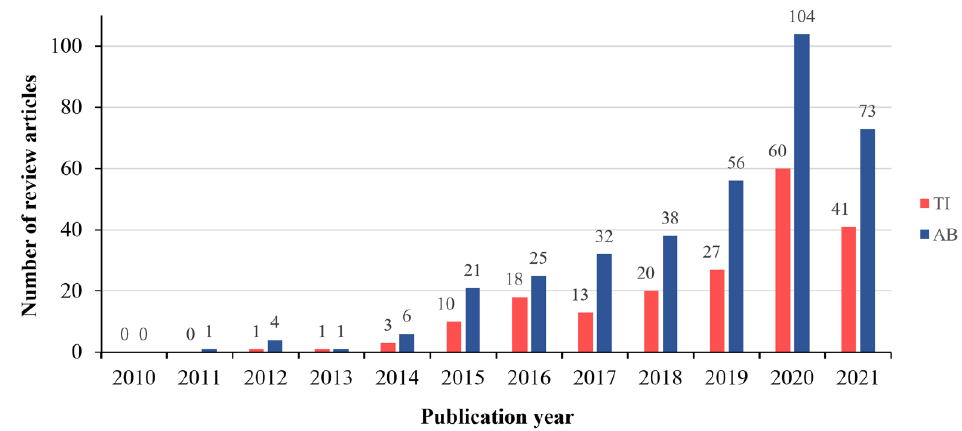
Figure 2. The number of review articles related to g-CN containing the words “graphitic carbon nitride or g-C 3 N 4 or g-CN” in the title and the word “review” in the abstract (TI) or the words “graphitic carbon nitride or g-C 3 N 4 or g-CN and review” in the abstract (AB) (Source: Web of Science (https://www.webofscience.com/wos/woscc/basic-search), accessed on 25 July 2021).